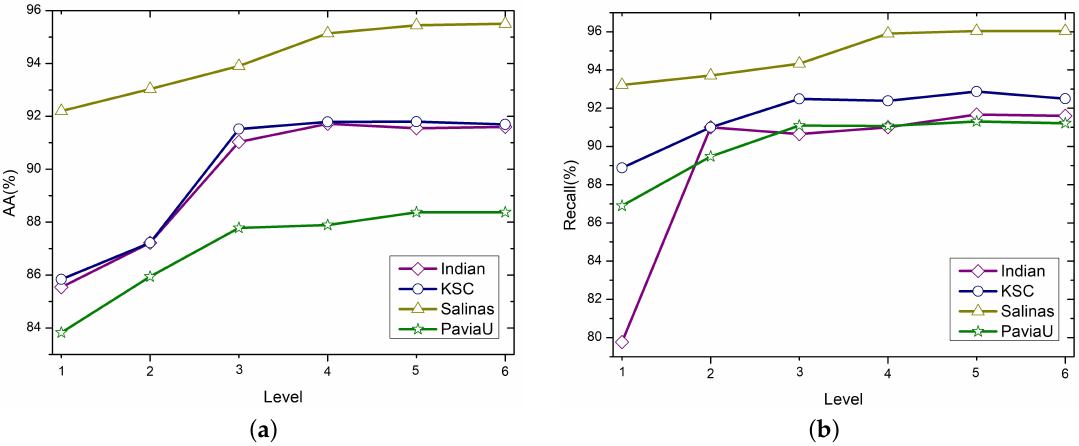
Figure 7. ( a ) Evolution of the AA according to level. ( b ) Evolution of the Recall according to